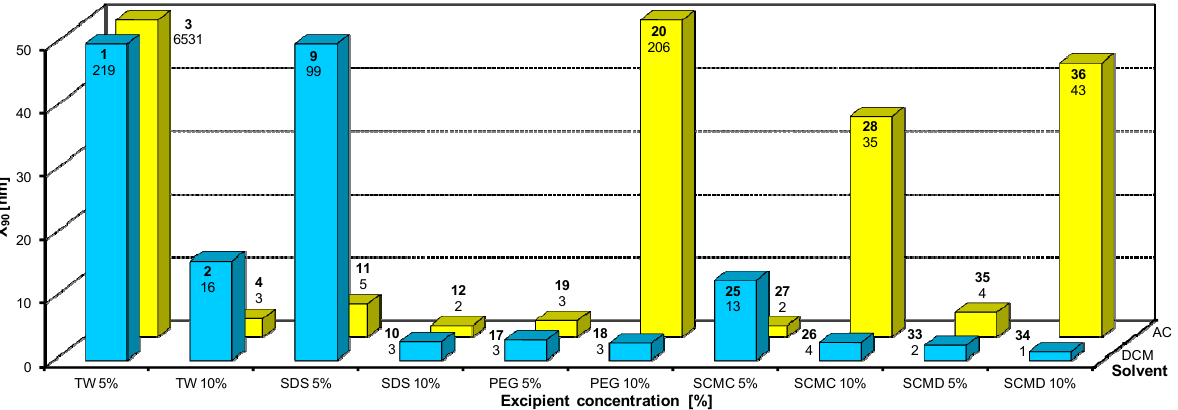
Figure 7. Dependence of particle size (x [nm]) of candesartan cilexetil ( I ) on 90 concentration [%] of Tween 80 (TW), sodium dodecyl sulfate (SDS), macrogol 6000 (PEG), sodium carboxymethyl cellulose (SCMC), sodium carboxymethyl dextran (SCMD) in dichloromethane (DCM) or acetone (AC). For clarity sake, the values on y-axis are only to 50 nm.